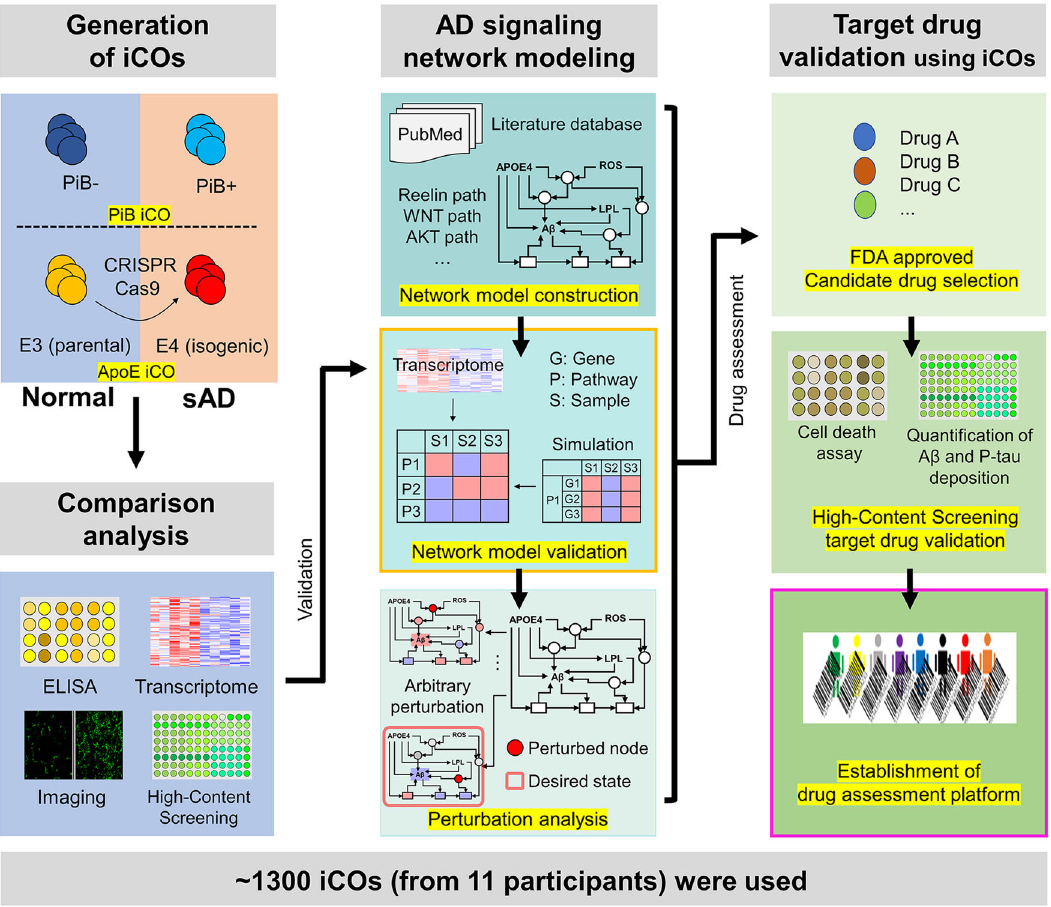
Fig. 1 The overall scheme of this study. To establish drug assessment platform for Alzheimer ’ s disease (AD), three steps were performed: (i) Generation of iPSC-derived organoids (iCOs) both from normal and sporadic AD (sAD) participants, and CRISPR-Cas9 ApoE4 isogenic lines were used. (ii) Systems biology-based AD pathway simulation; Signaling network construction, network model validation, and identi fi cation of control nodes steps were conducted. (iii) Validation of drugs from the simulation; FDA-approved drugs were used, and the degree of AD pathogenesis was quanti fi ed by the high-contents screening (HCS) imaging system. Approximately, 1300 organoids from 11 participants were used for the drug assessment platform. PiB Pittsburgh compound B, ApoE apolipoprotein E, ELISA enzyme-linked immunosorbent assay, A β beta-amyloid, p-tau phosphorylated